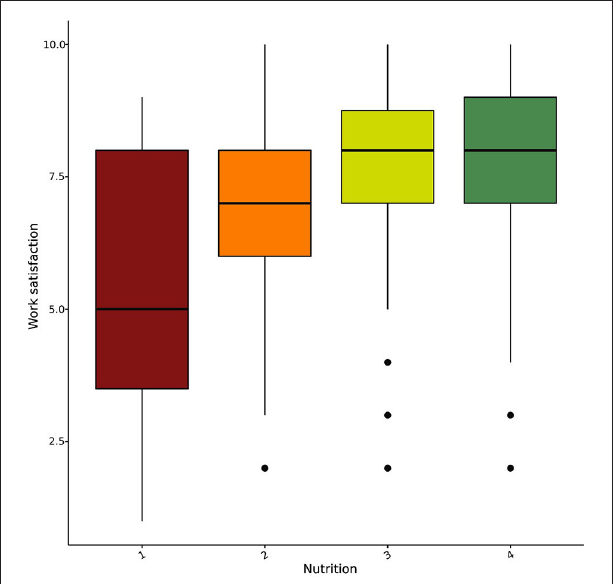
FIGURE 6 | Job satisfaction grouped by the self-rated quality of respondents’